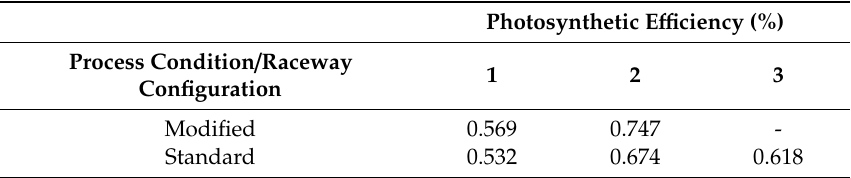
Table 4. Photosynthetic e ffi ciency of N. oceanica cultures obtained when growing in the two raceways tested. Values represent an average of two biological